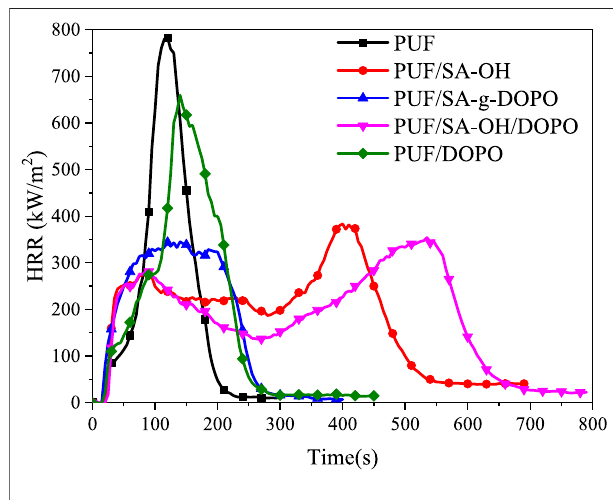
FIGURE 9 | HRR curves of PUF